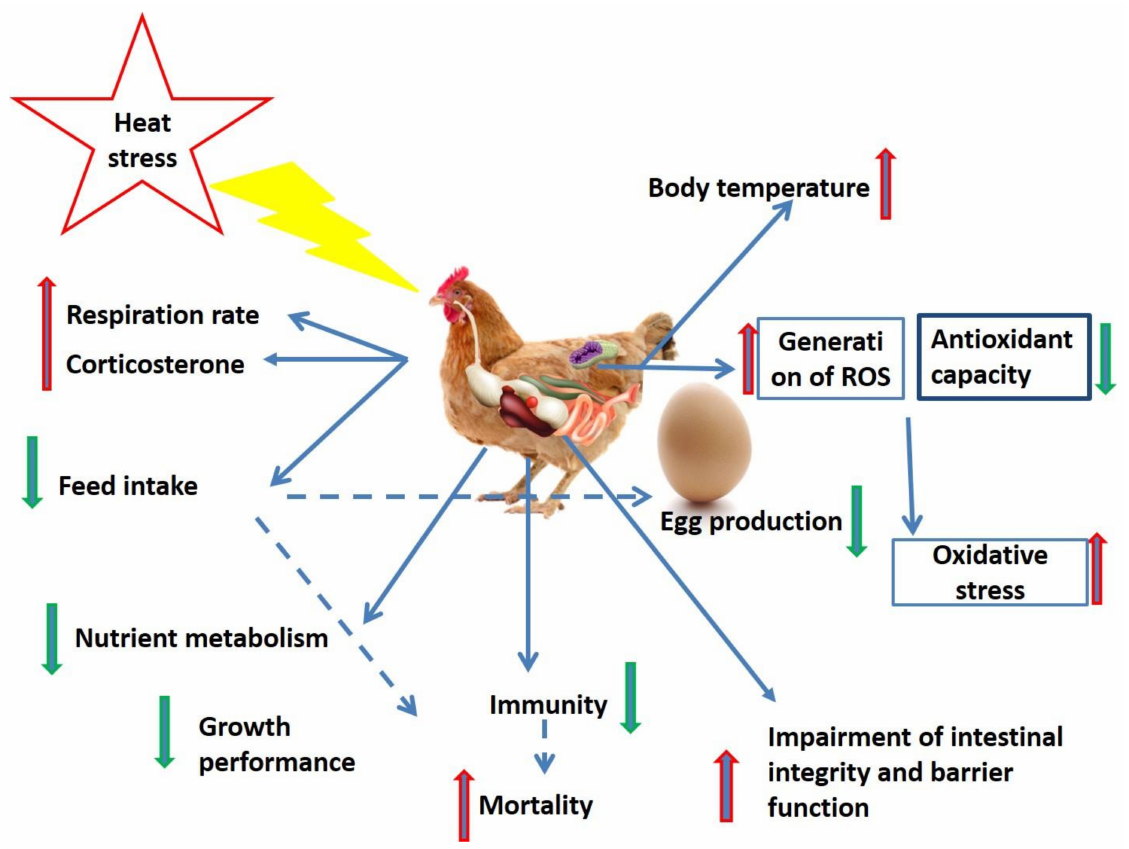
Figure 1. Undesirable e ff ects of heat stress on commercial